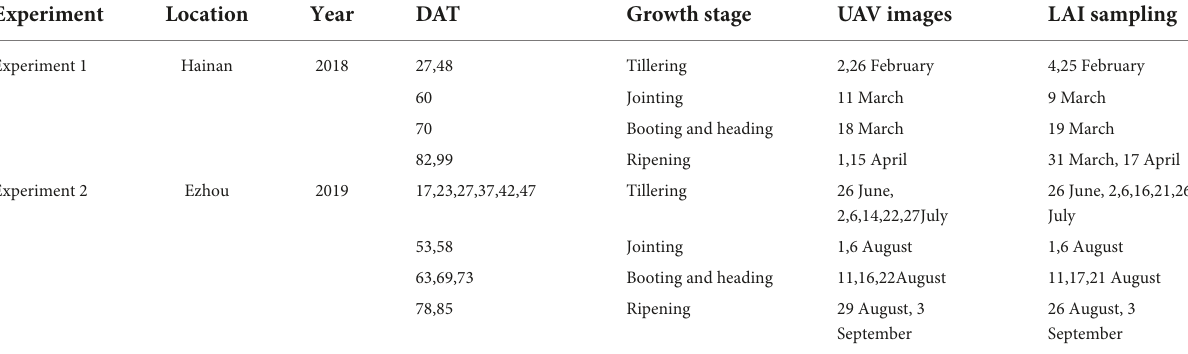
TABLE 1 Details of data acquisition for the two experiments.